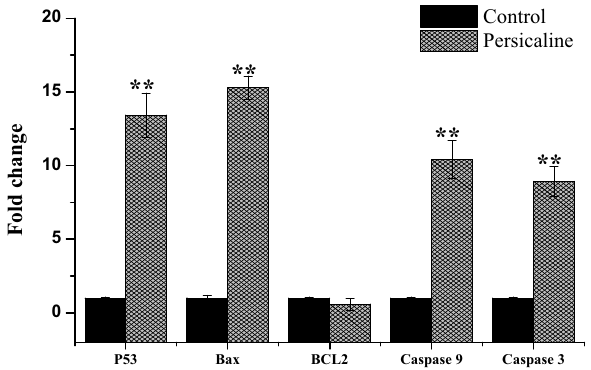
Figure 5: E ff ects of persicaline on the activity of apoptosis - related genes in MCF - 7 cells using qRT - PCR. Cells were treated with vehicle ( dimethyl sulfoxide ) or indicated concentration of persicaline ( 30 µg/mL ) for 24 h. Results are expressed as mean ± SD ( n = 3 ) . ** p < 0.01 compares the treated cell with control